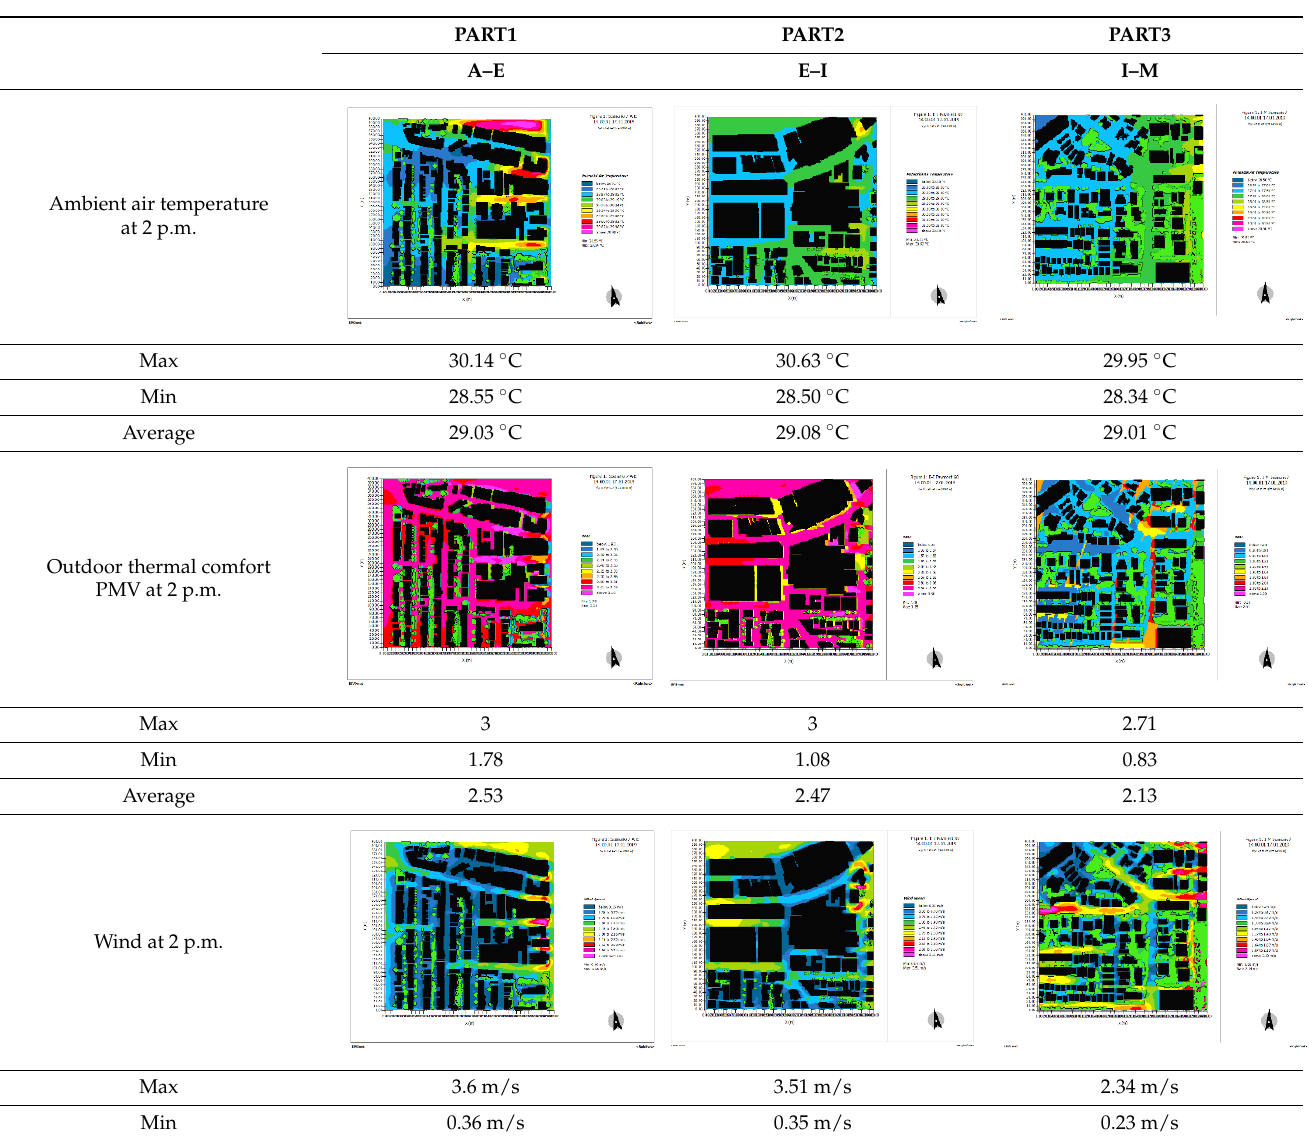
Table 14. Scenario seven ambient air temperature, outdoor thermal comfort, and wind speed dis- tribution map in all parts at 2 pm.